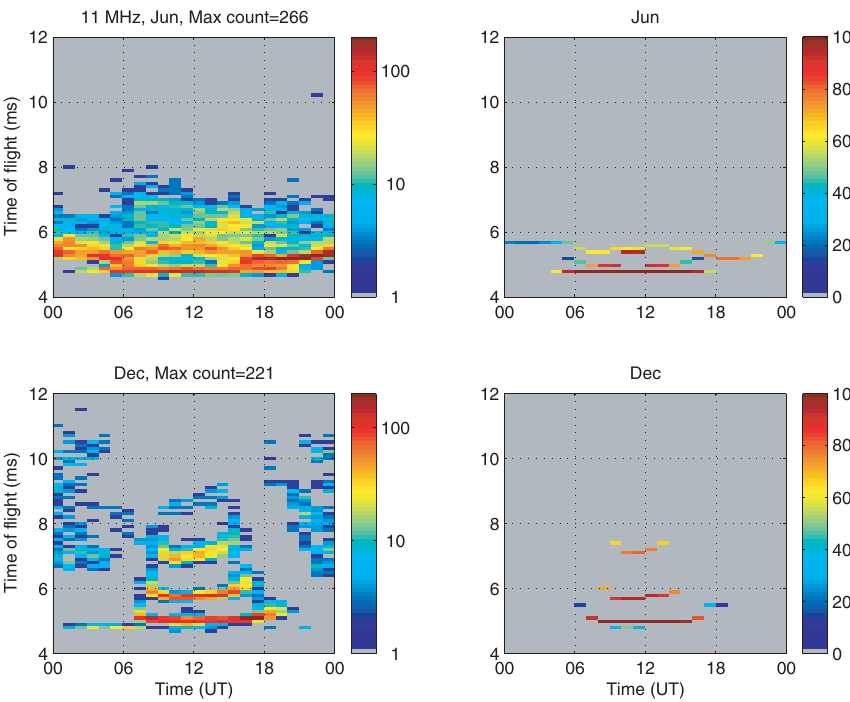
Fig. 14.3. Time of flight versus time of day for a signal of 11.1 MHz in summer ( top panels) and winter ( bottom panels). The left-hand panels are derived from experimental data. The colour scale indicates the number of observa- tions ( i.e. a measure of the probability of occurrence). The right-hand panels are derived from VOACAP predictions. The colour scale gives the percentage of days for which the mode MUF is above the operating